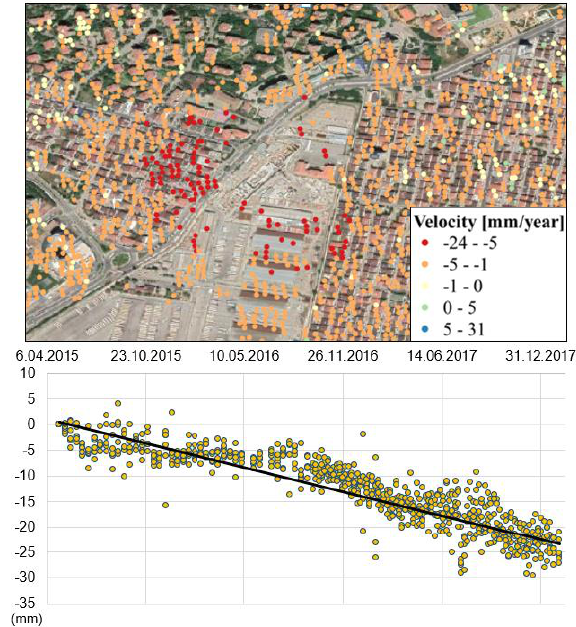
Figure 7. An urban site located near to the new metro station construction, and the time series of red coloured PS points over the Google Earth